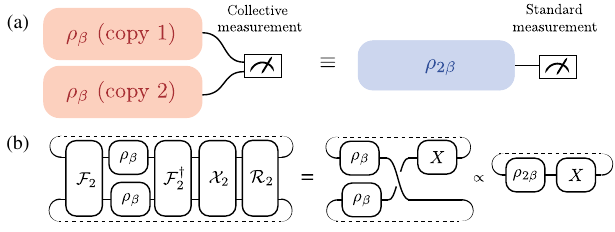
FIG. 1. (a) Schematic representation of the virtual cooling protocol. Collective measurements on two copies of a thermal state ρ β at temperature T ¼ 1 = ð k B β Þ correspond to standard measurements at half the temperature, T= 2 . (b) Diagrammatic representation. Two copies are evolved with the unitary F 2 , and a subsequent measurement of X 2 and R 2 is performed. In combination, this gives the expectation value tr f ρ β ρ β X g ∝ tr f ρ 2 β X g corresponding to half the original temperature. We can also measure the proportionality constant with a similar